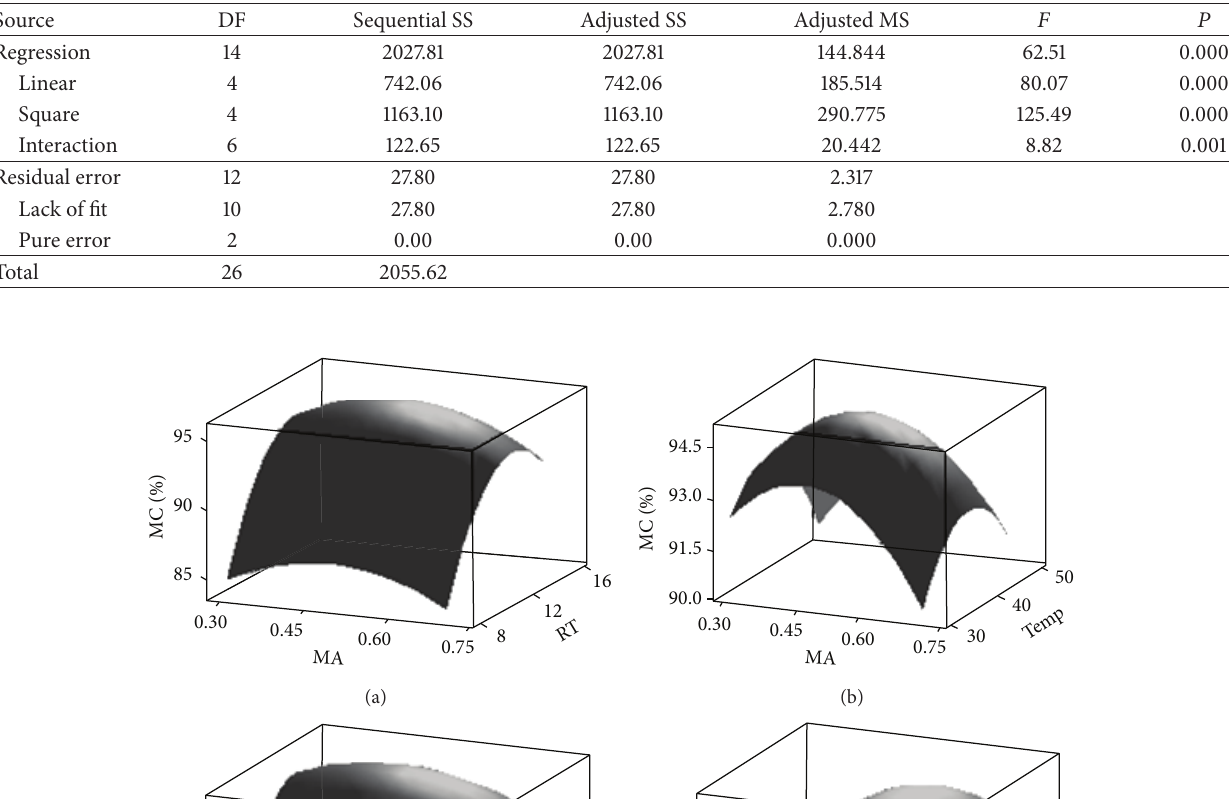
Table 4: Results of ANNOVA-lipase activity.